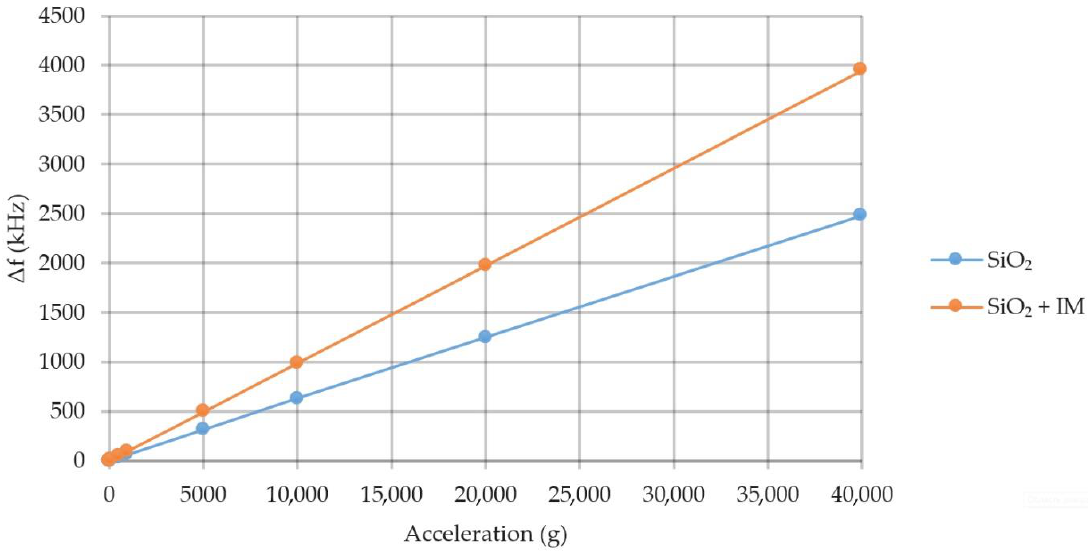
Figure 17. Graph of the frequency change under acceleration.